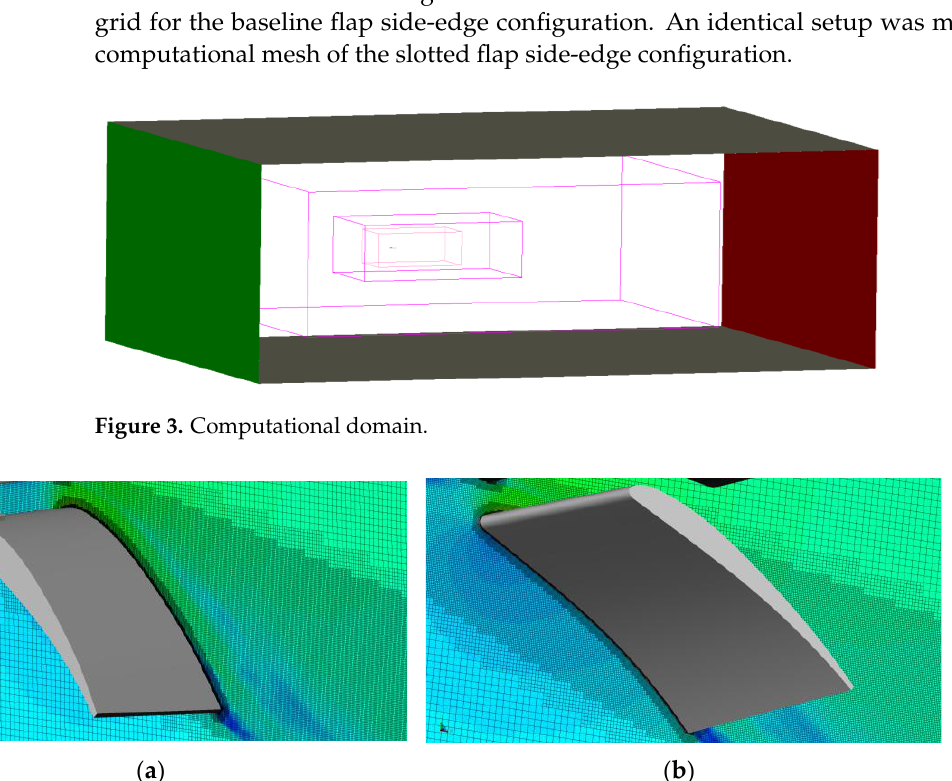
Figure 3. The inlet is denoted by the green surface, and the red surface represents the outlet; the other four surfaces were set as the solid slip wall boundary condition.